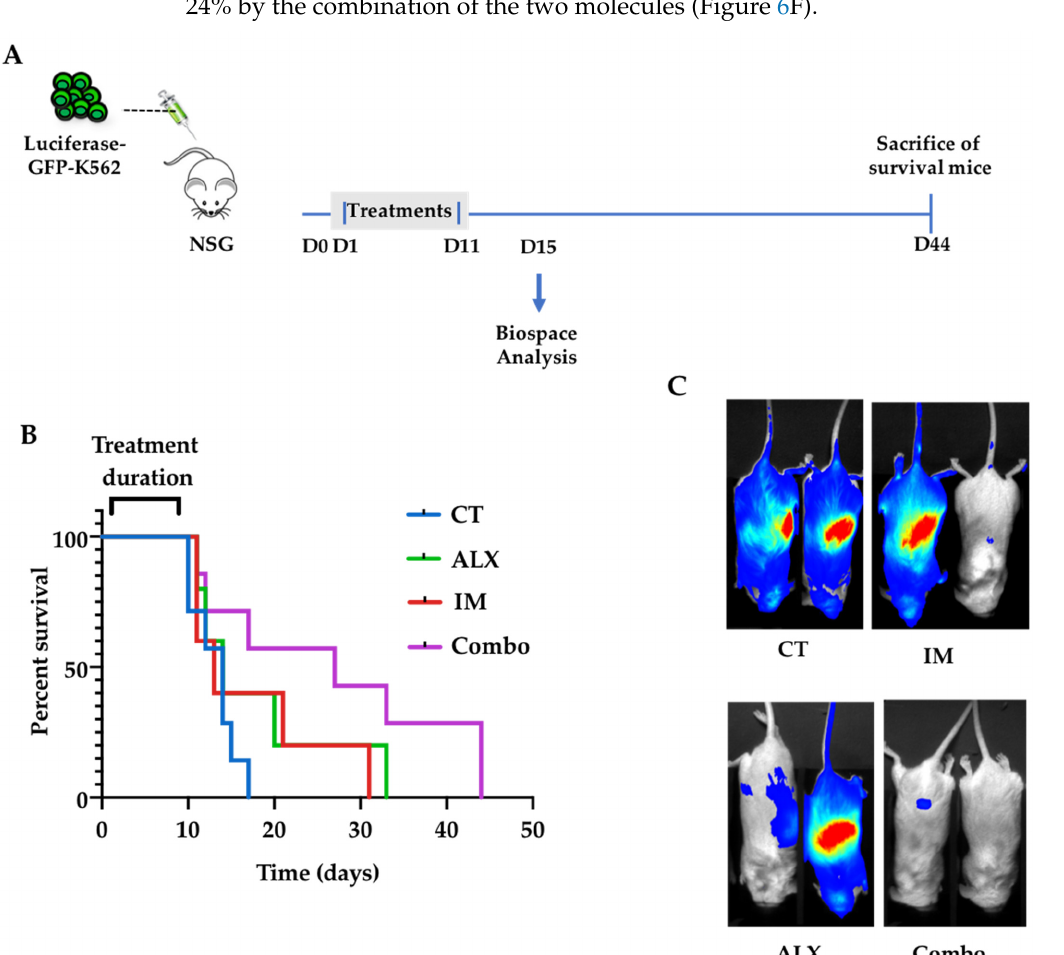
Figure 6. Combination of alexidine and imatinib increased leukemic mice’s survival. ( A ) Schematic design of the in vivo experiment. NSG mice (7 per group) were injected intravenously with GFP- K562-transduced cells. One day later, the mice were treated daily for 10 days with intraperitoneal